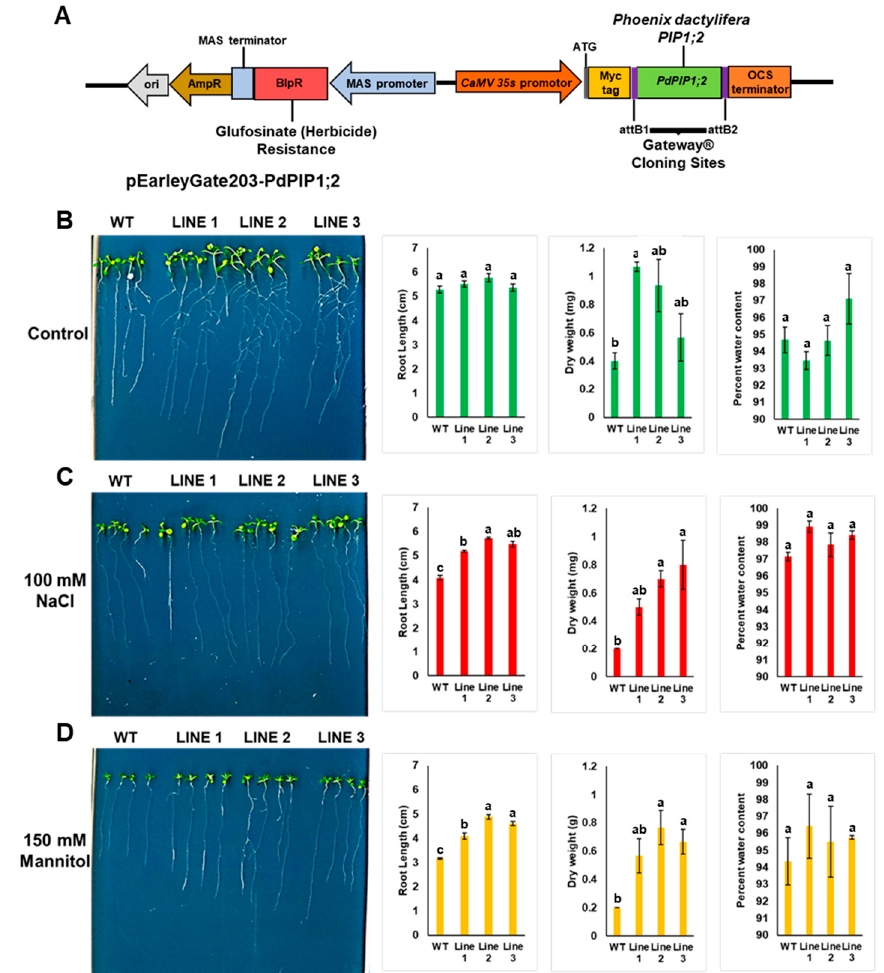
Figure 8. Heterologous overexpression of PdPIP1;2 enhanced drought and salt tolerance in Arabidopsis. Schematic representation of cloned PdPIP1;2 gene in pEarleyGate203 plasmid for overexpression in Arabidopsis ( A ) The growth pattern, root length, dry weight and water content percentage measurements in WT and transgenic Arabidopsis lines with PdPIP1;2 grown in plane control ( B ), 100 mM NaCl ( C ), or 150 mM mannitol media ( D ) for 14 days. The length of the main root was measured manually using a standard centimeter scale. The bars represent either the mean root length in cm or dry weight in mg (± SE, n = 3), while the asterisks indicate a significant difference to WT at p < 0.05.